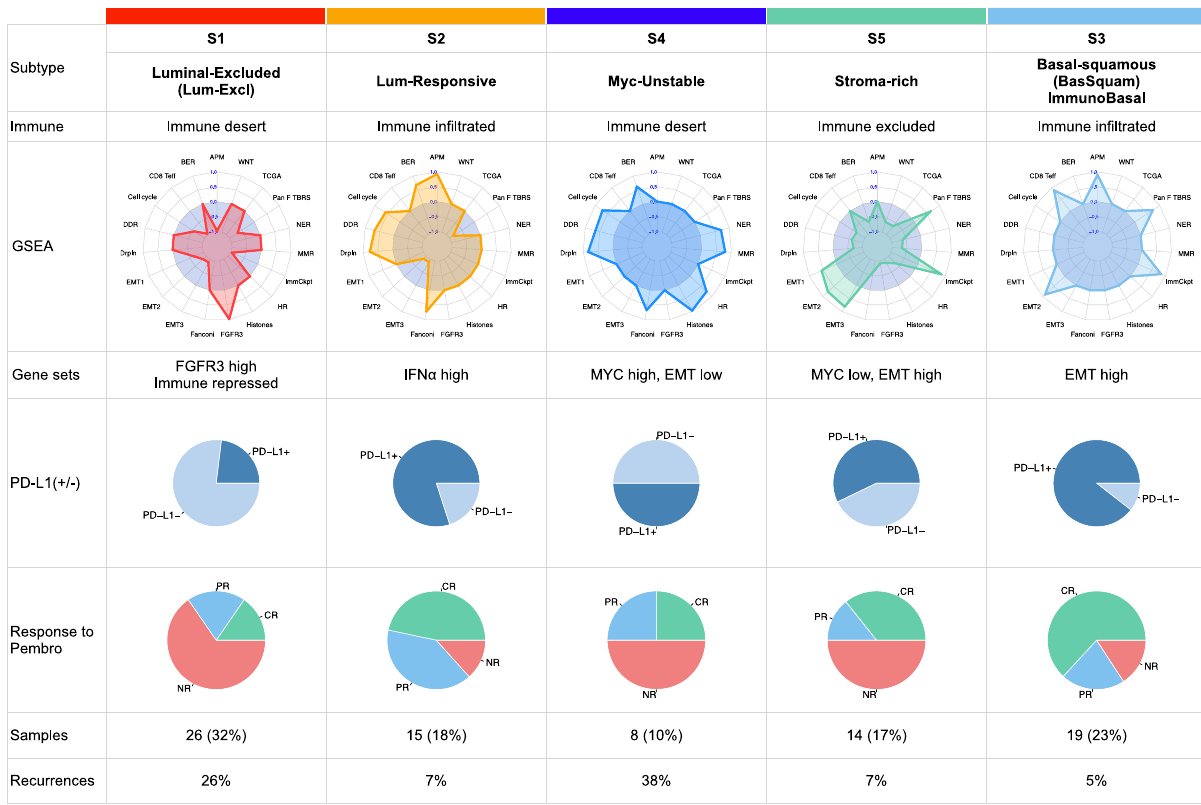
qval <0.05, or p adj >0.1; GSEA summary, largely from MSigDB Hallmark gene sets; PD-L1status(CPS>10%forPD-L1+);responsetopembrolizumabtreatment(CR,PR, NR);numberofsamplesandpercentofthe n =82cohort;and fi nallythepercentof samples in a subtype that had recurrences within 24